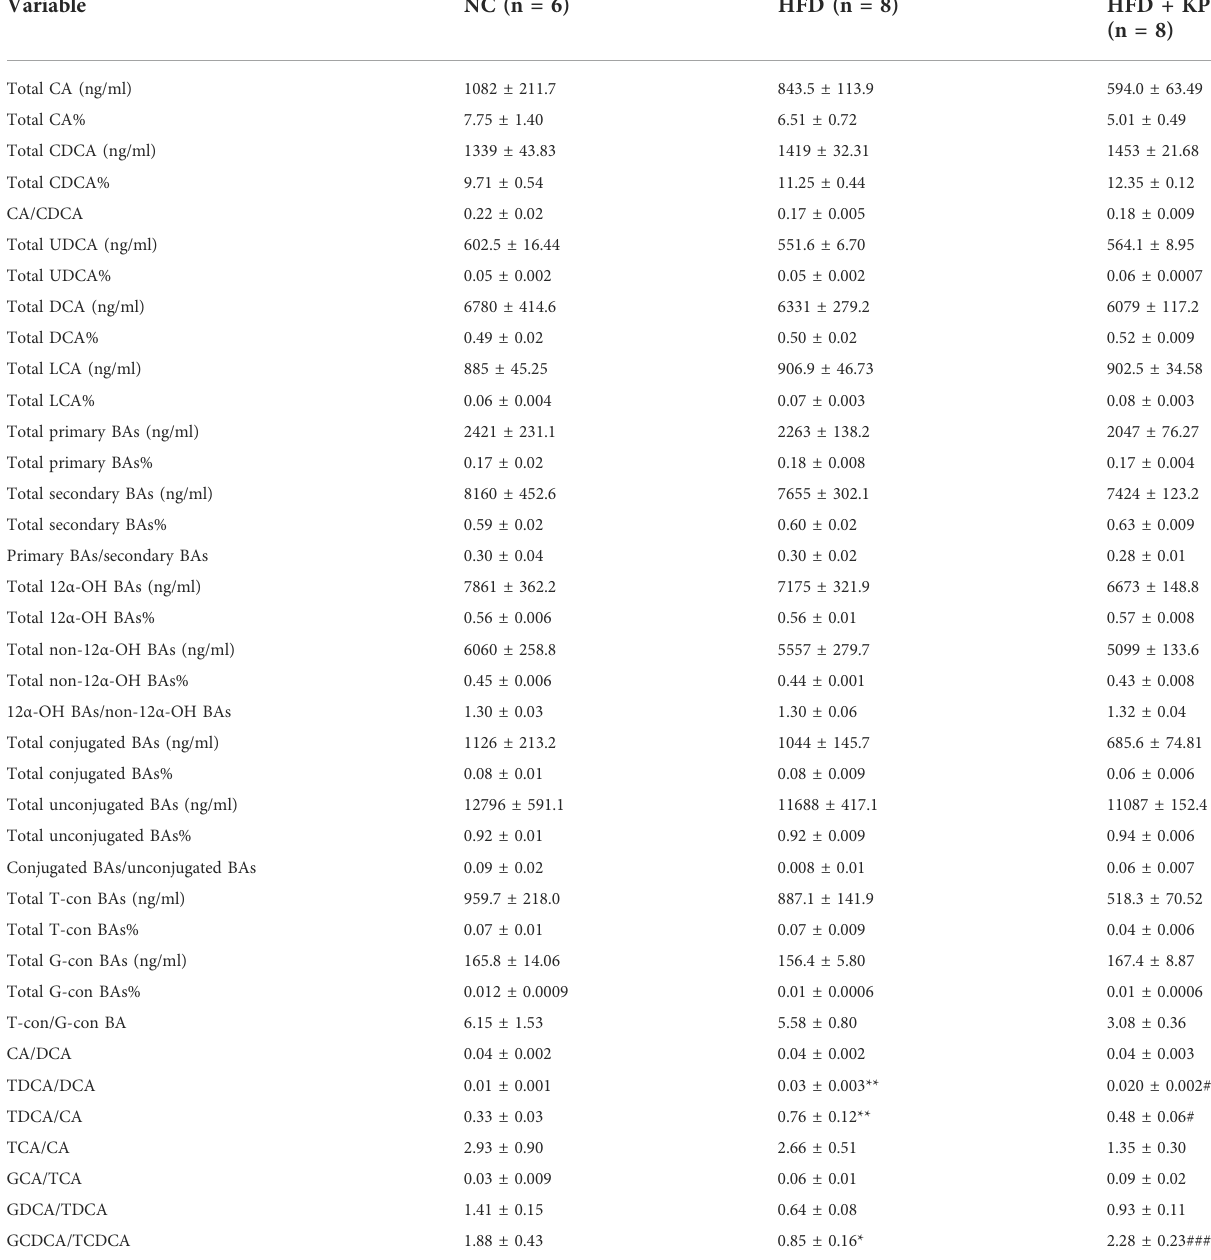
TABLE 2 Serum BA ratios and percentage altered signi fi cantly among three